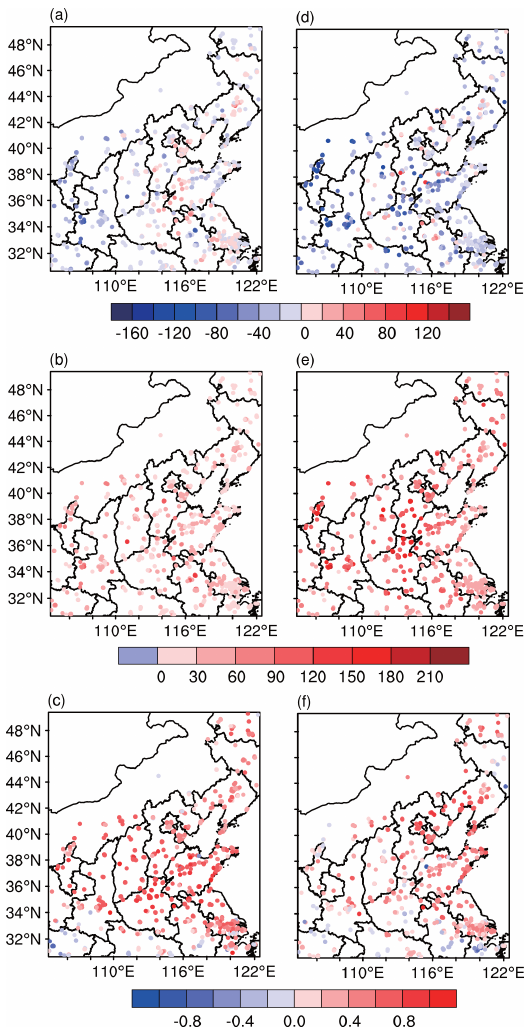
Figure 6. The (a, d) bias (µgm − 3 ), (b, e) RMSE (µgm − 3 ) and (c, f) correlation coefficient (1) averaged (a–c) during the clean pe- riod (3 to 5 December) and (d–f) the polluted period (6 to 10 De- cember).